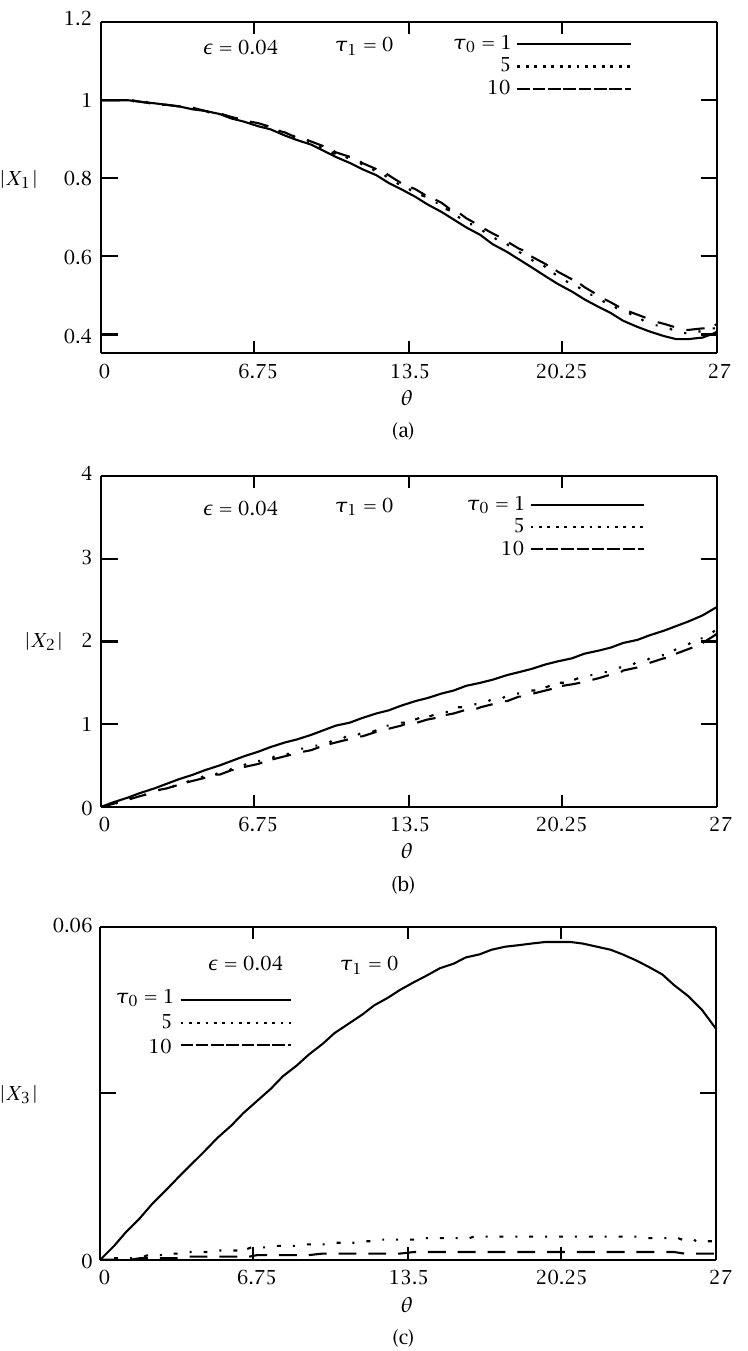
Figure 7 . (The effect of the thermal relaxation time in L-S theory) | X 1 | , | X 2 | , | X 3 | versus the angle of incidence θ